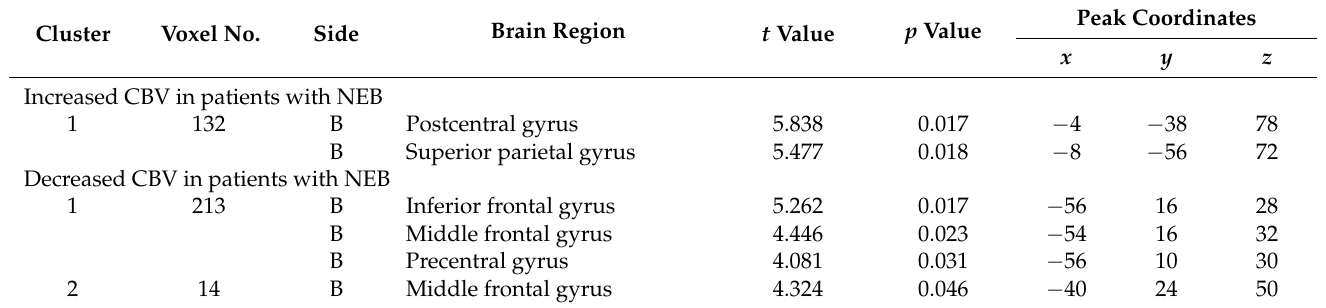
Table 4. Clusters of increased or decreased CBV in NEB group relative to